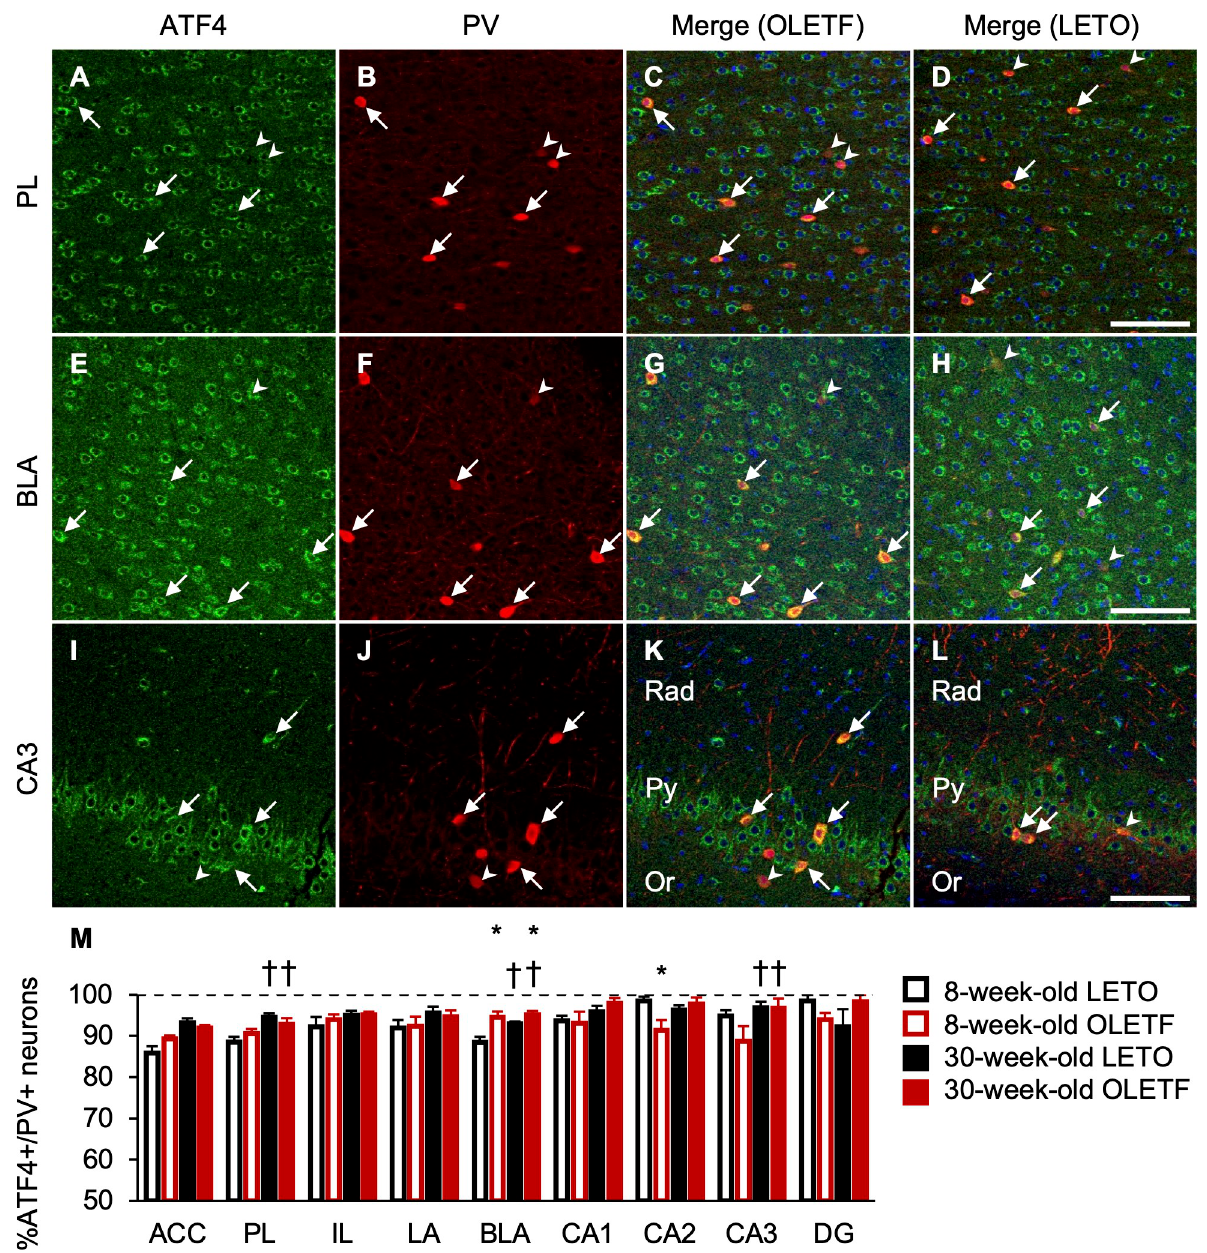
Fig 8. ATF4- and PV-positive neurons in the corticolimbic system. Representative immunofluorescent images of 8-week-old OLETF and LETO rats in the prelimbic cortex (PL; A , B , C and D ), basolateral amygdala (BLA; E , F , G , and H ), and hippocampal cornu ammonis area 3 (CA3; I , J , K , and L ). Labeling for activating transcription factor 4 (ATF4; A , E , and I ) and parvalbumin (PV; B , F , and J ) and merged images ( C , G , and K for OLETF rats; D , H , and L for LETO rats). Arrows or arrow heads indicate neurons expressing ATF4 and PV or only PV, respectively. Scale bars = 100 μ m. Rad: radiatum layer; Py: pyramidal cell layer; Or: oriens layer. The percentages of neurons co-expressing ATF4 and PV in the anterior cingulate cortex (ACC), PL, infralimbic cortex (IL), lateral amygdala (LA), BLA, CA1, CA2, CA3, and dentate gyrus (DG; M ). ATF4+: ATF4-positive; PV+: PV-positive. Values represent mean ± standard error of means. � Significant difference from age-matched LETO rats, p < 0.01; † significant difference from same strain at 8 weeks of age, p < 0.05, two-way ANOVA.